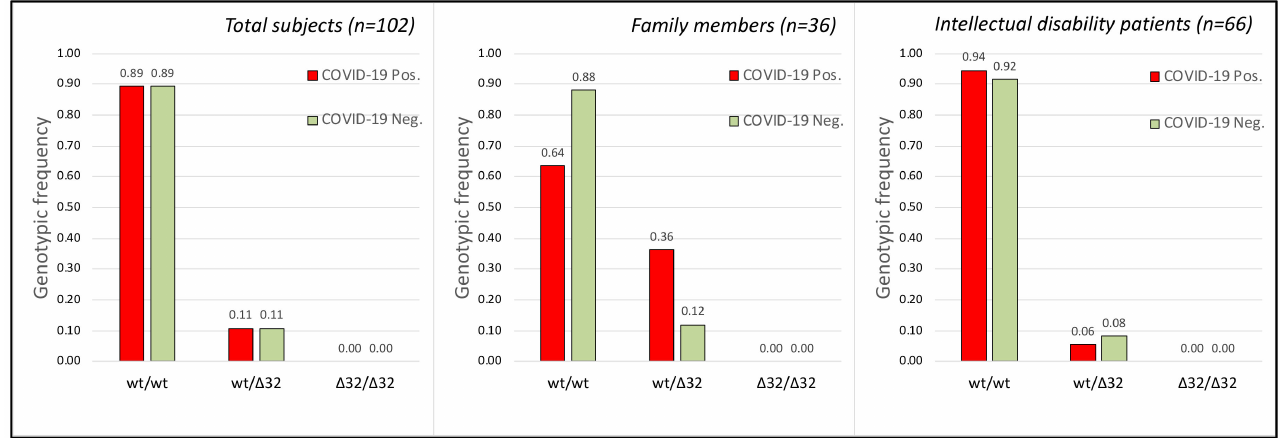
Figure 3. Frequency of the three genotypes obtained by the wild-type (wt) and ∆ 32 alleles of the rs333 SNP polymorphism (CCR5 gene) in the analyzed groups. ( Left ) Genotype frequency in the total subjects (Chi-square Test for 2 2: Chi = 0.00004 p = 0.995 df = 1; Sample size = 102; power × = 0.15933). ( Middle ) Genotype frequency in the subjects belonging to the analyzed families with cohabiting members (Chi-square Test for 2 2: Chi = 2.8948 p = 0.0888; df = 1). ( Right ) Genotype × frequency in the subjects belonging to the intellectual disability patients cohabiting in the Oasi M. Santissima IRCCS (Troina, Italy). Each group was subdivided into infected (COVID-19 Pos.) and non-infected (COVID-19 Neg.) groups. Chi-square Test for 2 2: Chi= 0.1331 p = 0.7153; df = 1). No × statistically significant correlation was obtained between SARS-CoV-2 infection and the rs333 SNP